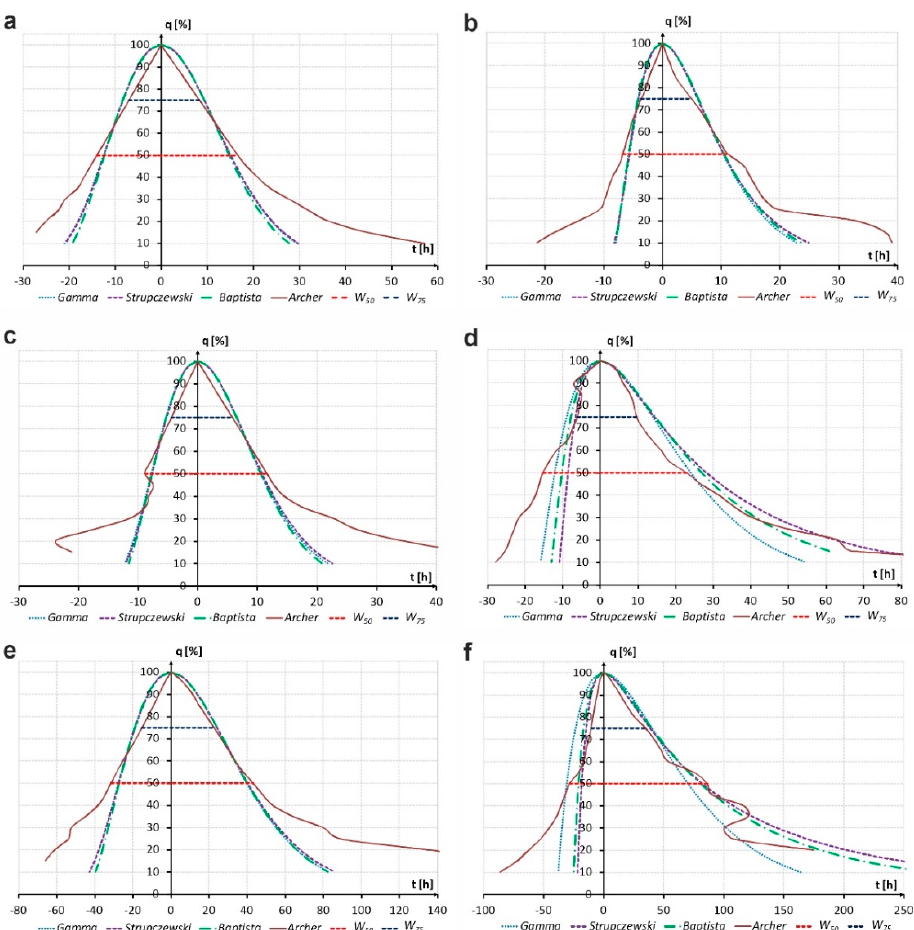
Figure 5. Plots of nonparametric DFH developed according to the Archer method and parametric DFHs (Gamma, Strupczewski and Baptista methods) for selected gauging stations/rivers: ( a ) Lubie ń /Lubie ń ka, ( b ) Ś wierzawa/Kaczawa, ( c ) Kasinka/Raba, ( d ) Wojanów/Bóbr, ( e ) Sandomierz/Wis ł a and ( f ) Bóbr/ Ż aga ń . Table 2. The values of parametric DFH characteristics W 50 , W 75 and s estimated with the use of the analyzed methods: Gamma, Strupczewski and Baptista.